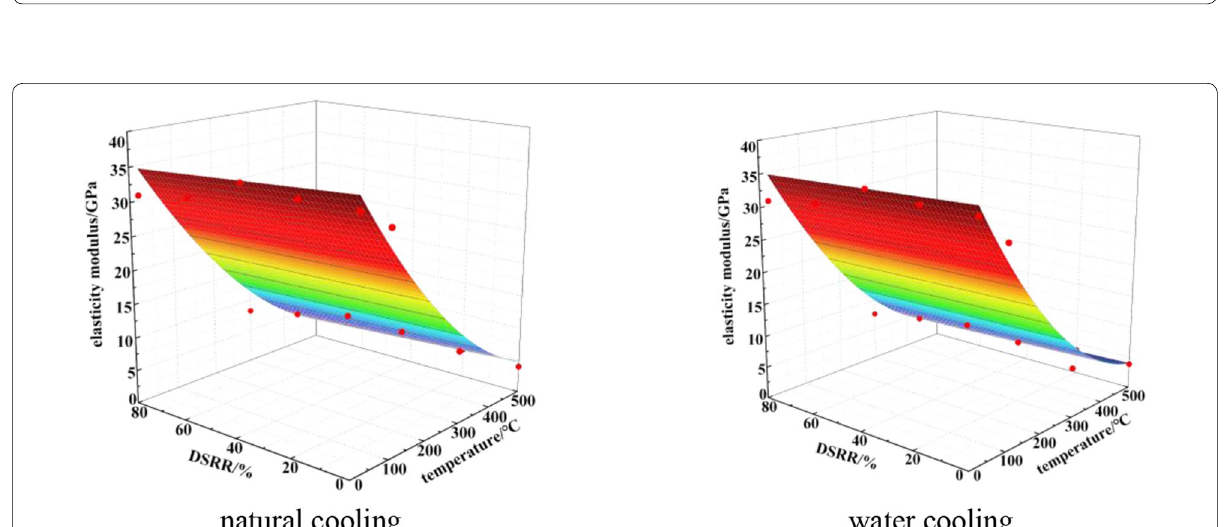
Fig. 16 Comparision of elasticity modulus between the predicated results from the regression model and experimental results of concrete produced with desert